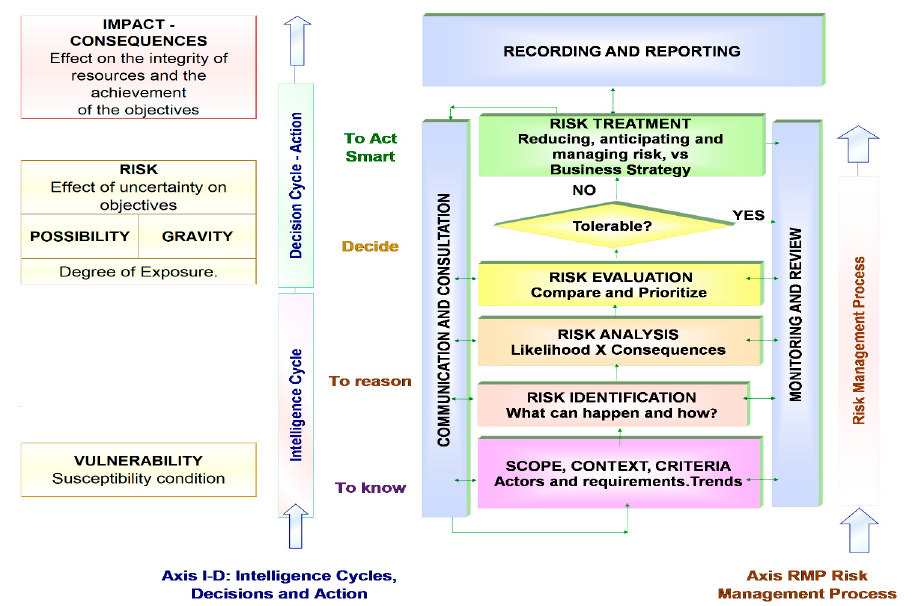
Figure 1. Relationship between the concepts of risk, risk management, intelligence, and decision- Figure1. Relationshipbetweentheconceptsofrisk, riskmanagement, intelligence, anddecision-making, making, based on ISO 31000, ISO Guide 73: 2009 and DHS USA, 2008 [13,14,19,20]. based on ISO 31000, ISO Guide 73: 2009 and DHS USA, 2008